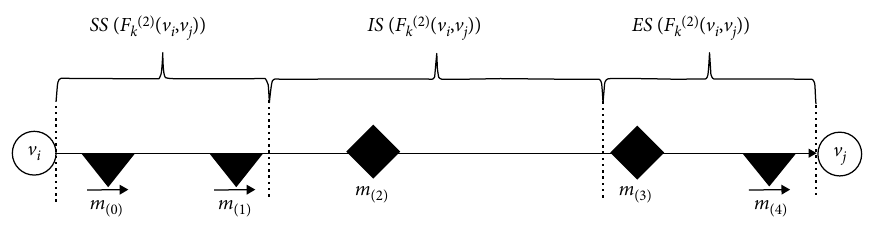
Figure 4: An example of Type 2